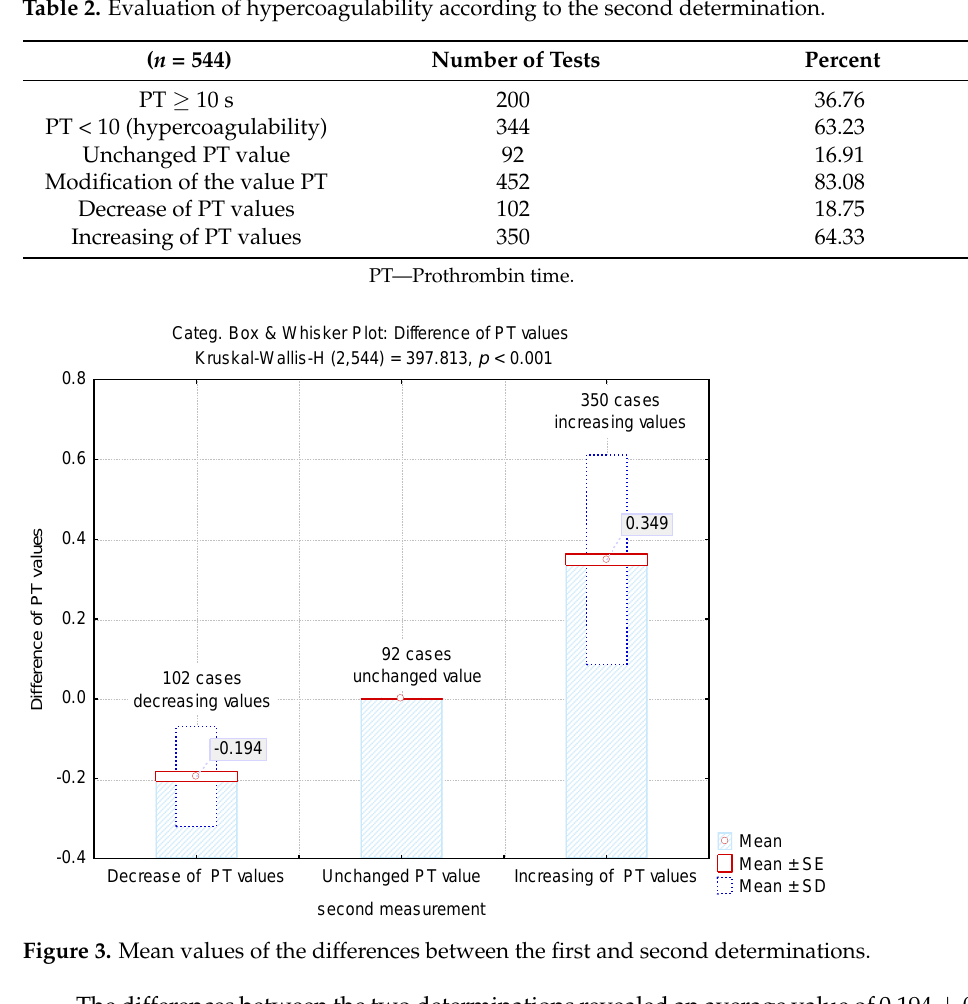
The differences between the two determinations revealed an average value of 0.194 ±